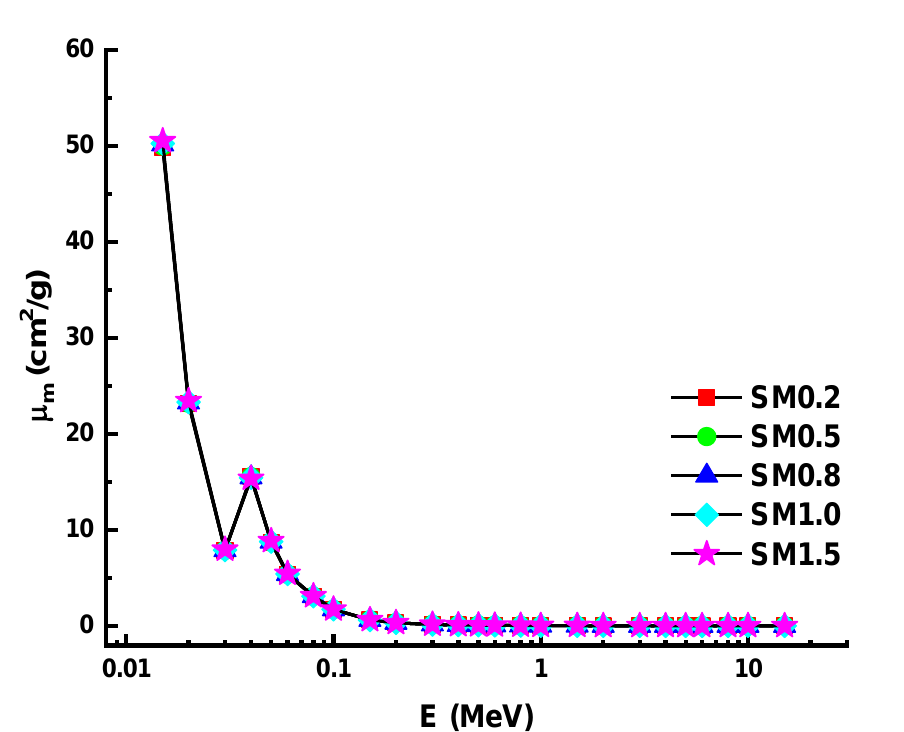
Figure 6. Variation of mass attenuation coefficient (µ m ) against Photon energy for all glasses.